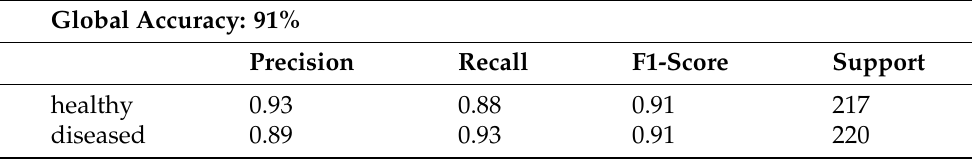
Table 4. Metric results for the test dataset. This set previously separated, taking 10% of all images.